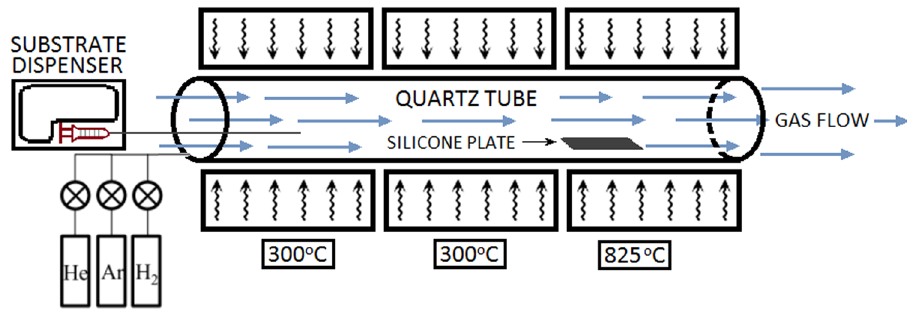
Figure 2: Scheme of CVD CNTs